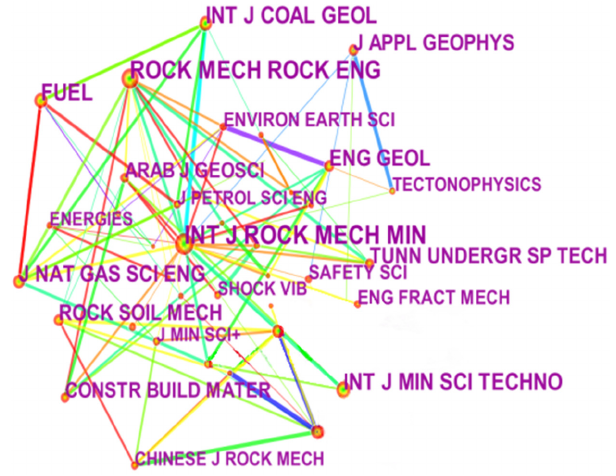
Figure 13. Journal co-citation network. Table 8. Statistical table of the number of articles published by the top ten journals. Table 7. Statistical table of the top ten cited journals.